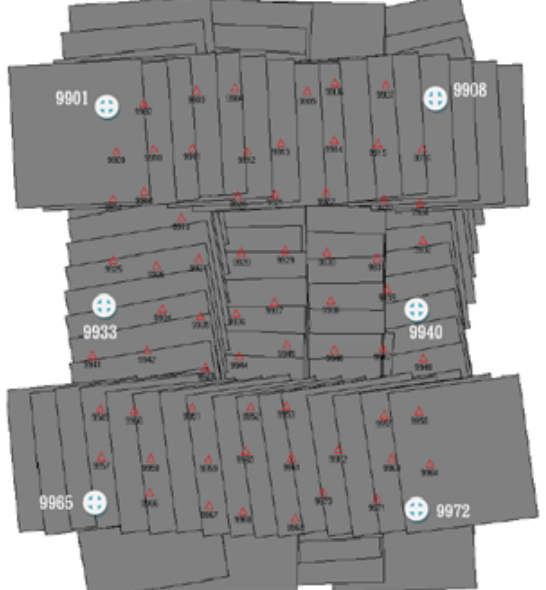
Figure 6. Overlap of all 108 test images, and locations of 6 ground control points and 65 check points